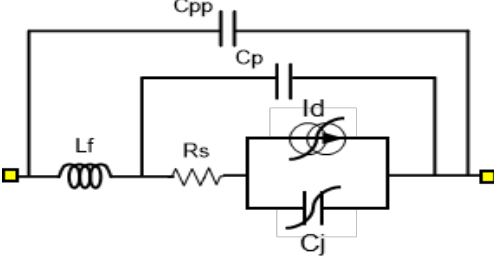
Figure 2. Diode equivalent circuit model.